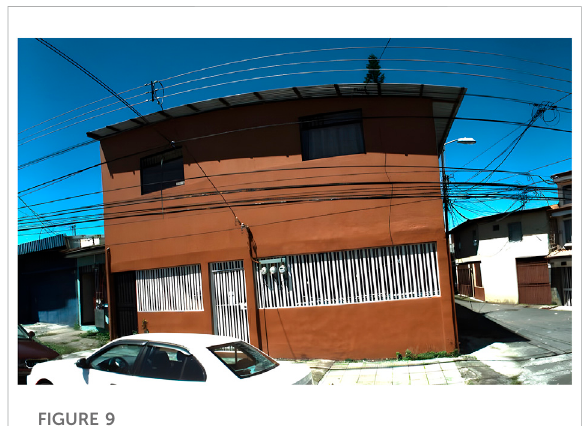
FIGURE 9 Example of a complete frontal enclosure of a dwelling.